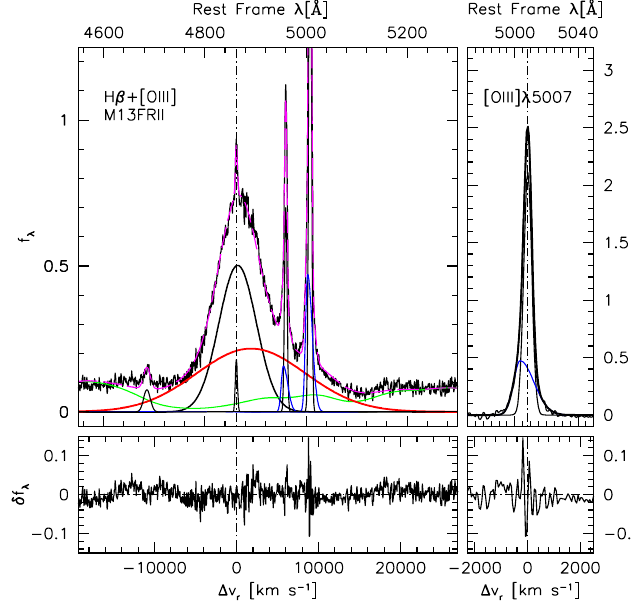
Figure 3. Analysis of the H β + [O III ] λλ 4959,5007 region for the RQ composite spectrum of Marziani et al. [45] ( top ), and for the CD and FR-II composite spectra ( middle and bottom , respectively). Color coding of the components is the same as in the previous